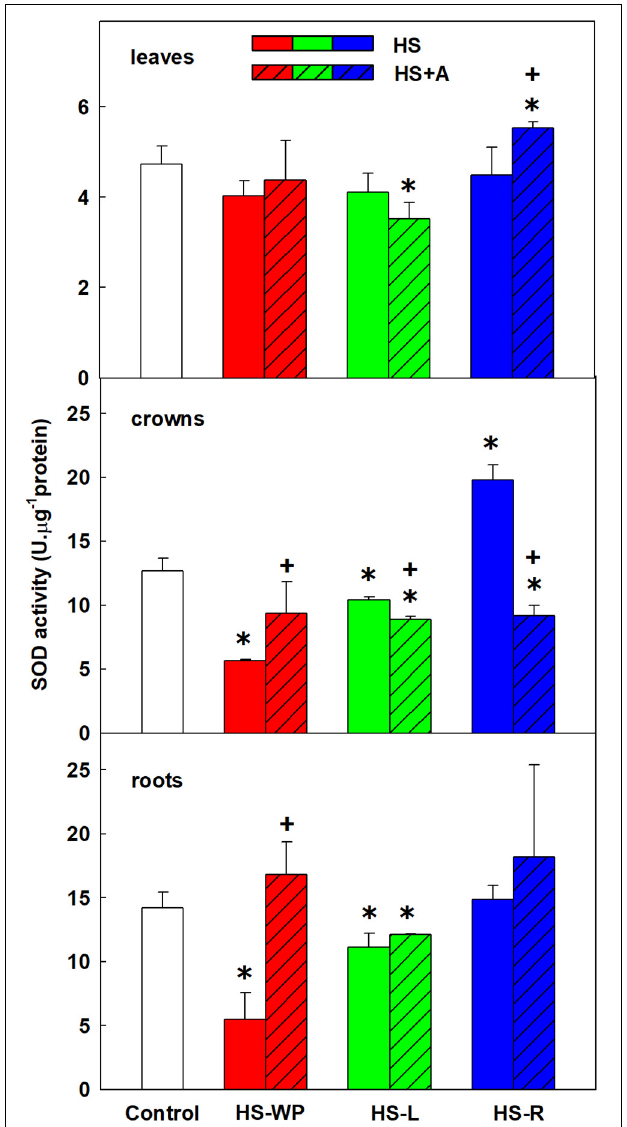
FIGURE 9 | Heatmap of changes in transcript levels of selected stress- and phytohormone-related genes. Gene expression was measured in leaves, crowns, and roots of rice seedlings under control conditions (control) and plants subjected to HS applied to whole plants (HS-WP), whole plants after acclimation (HS + A-WP), to leaves (HS-L), leaves after acclimation (HS + A-L), to roots (HS-R), and roots after acclimation (HS + A-R). Six independent biological samples were evaluated. Data in the heatmap are normalised against control levels separately for each tissue and time-point. The mean values are presented in log 10 colour scale. Means ± SD and other statistics are shown in Supplementary Table 2 . In some experimental groups, the AOX1b expression levels of most of the samples were under the detection limits of RT-qPCR, therefore they are not included in the results and marked as X. Heatmap was created using Prism 8 (GraphPad).